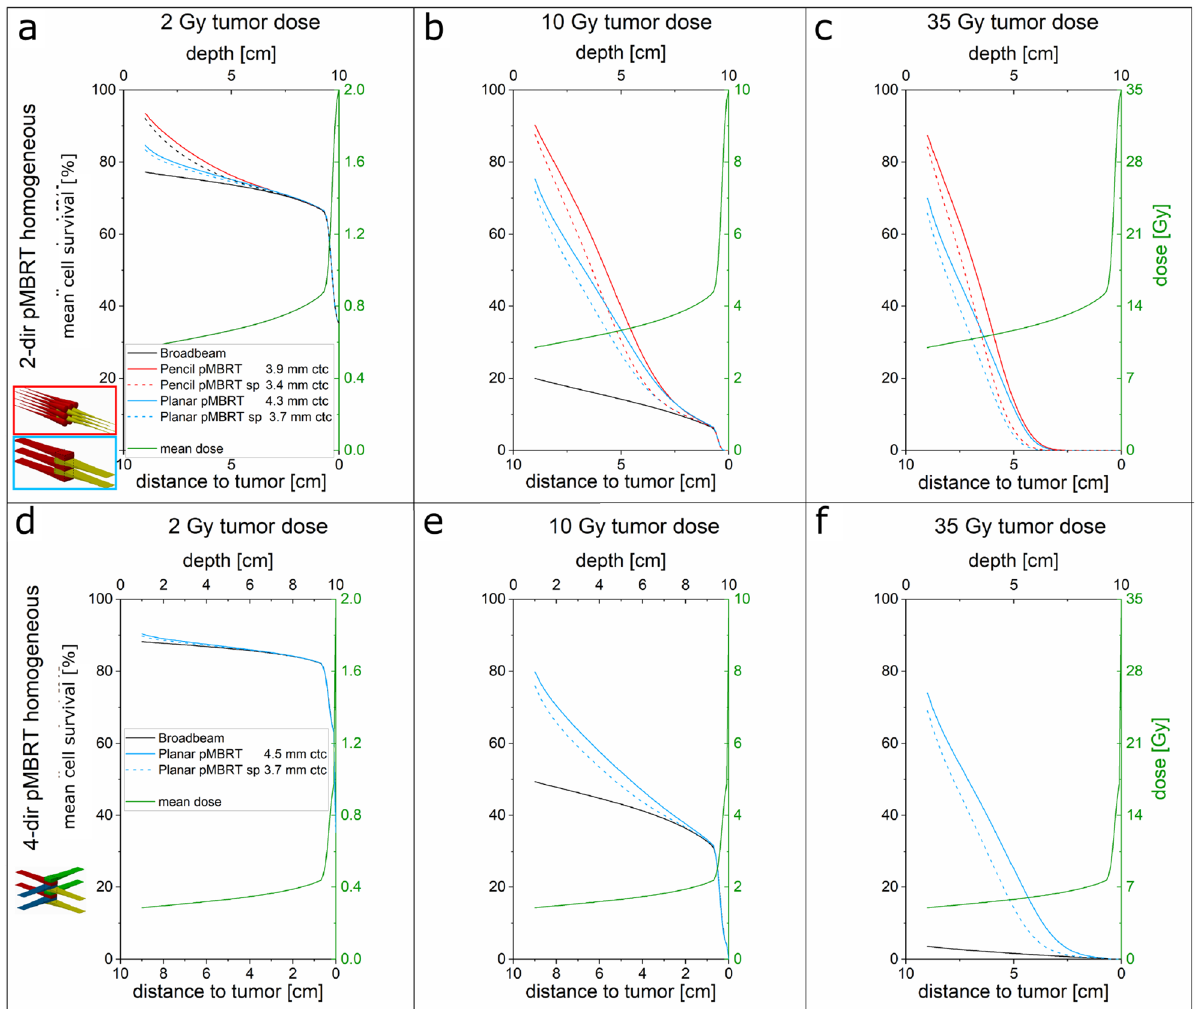
Figure 3. Mean cell survival for homogeneous tumor irradiation from two opposing directions ( a – c ) and four orthogonal directions ( d – f ). The tumor dose was set to 2 ( a , d ), 10 ( b , e ) or 35 Gy ( c , f ). “sp” is short for superposed and labels the irradiation by minibeams delivering a homogeneous tumor dose from each direction with half (2-dir) or quarter (4-dir) of the tumor dose delivered from each direction summing up to the prescribed tumor dose. The mean dose, which is the same for all irradiation modalities for homogeneous tumor irradiation, is added to each figure in green and corresponds to the y-axis on the